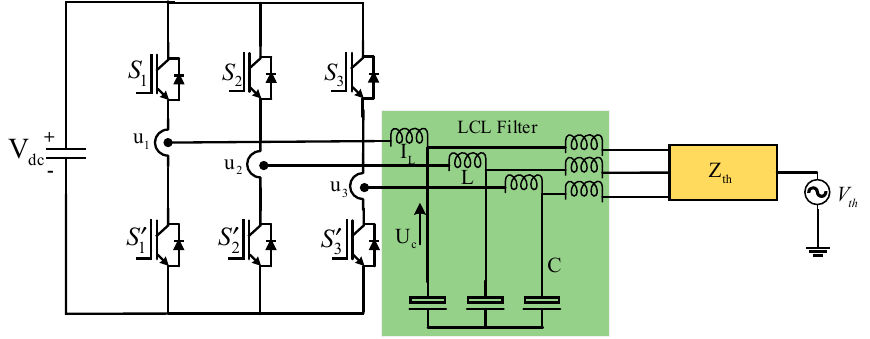
Figure 13. A Three-phase voltage source inverter in grid-connected mode.